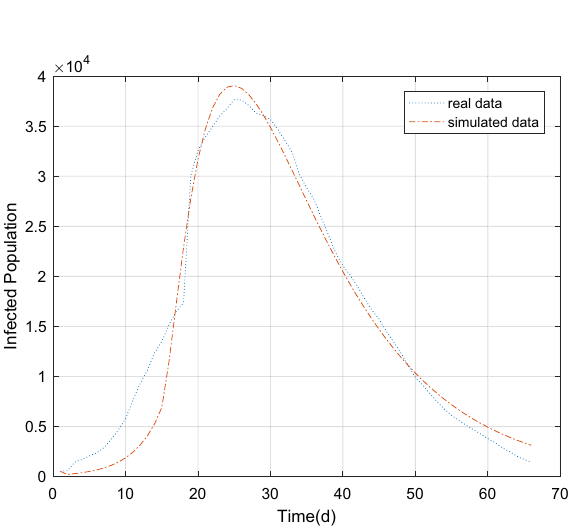
Figure 6. Comparison between simulated data and real data of the existing infected in Wuhan.